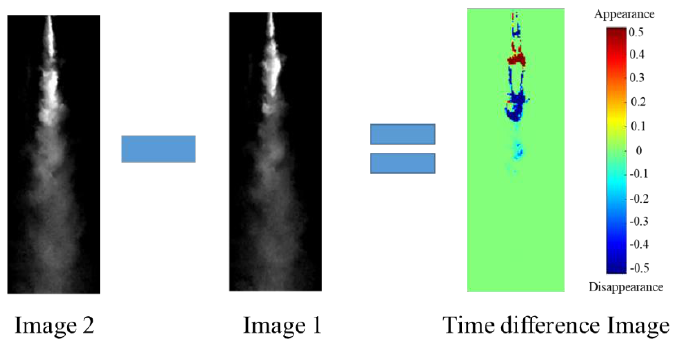
Figure 3. Frame-difference method.